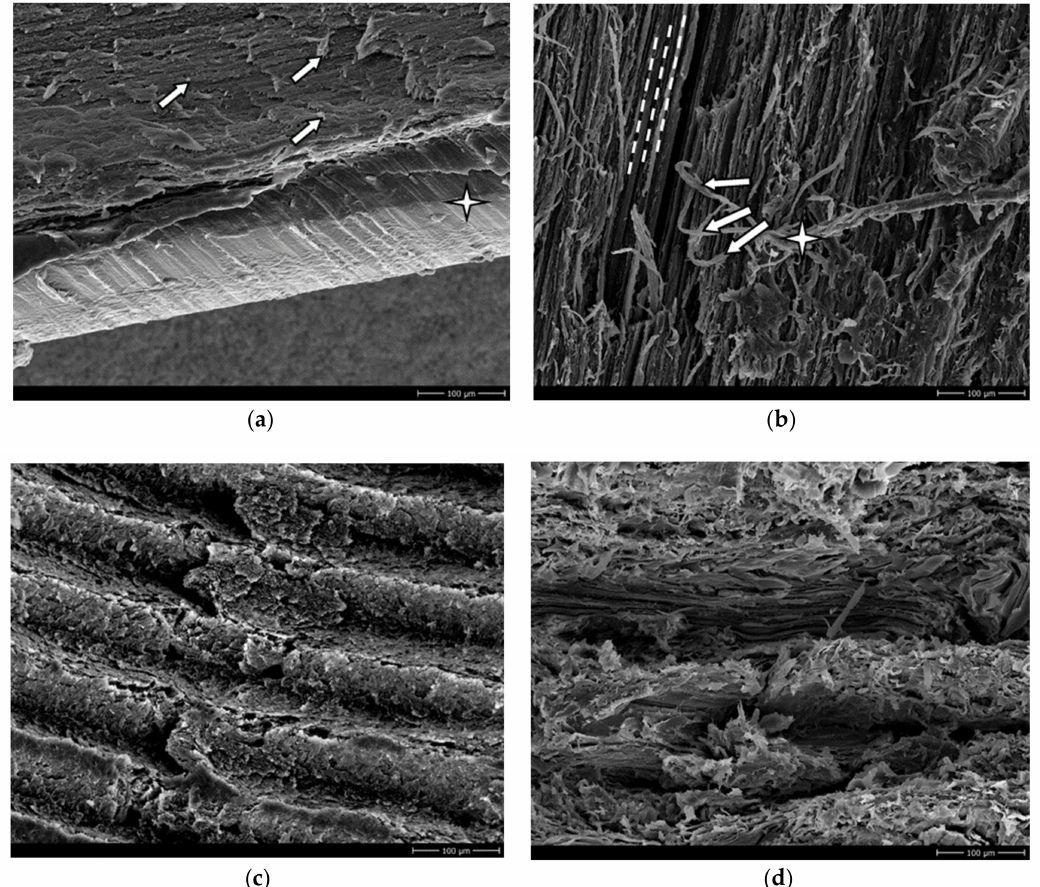
Figure 7. Scanning electron microscopy (SEM) images. Image ( a ) shows the cross-section of an ESD-ABS filament. The white arrows indicate the carbon particles, and the white star shows the surface of the filament. Image ( b ) has been taken from the cross section of ESD-PLA filaments, where the carbon threads are marked with white arrows, and a bigger piece of it with a white star. The discursive white lines indicate the orientation of the threads in the filament. Image ( c ) has been taken after printing with 100 micrometers. In direction X with ABS material, while ( d ) shows ESD-PLA with the same printing parameters. The brackets demonstrate 1 layer (size: 100 micrometers). Magnification